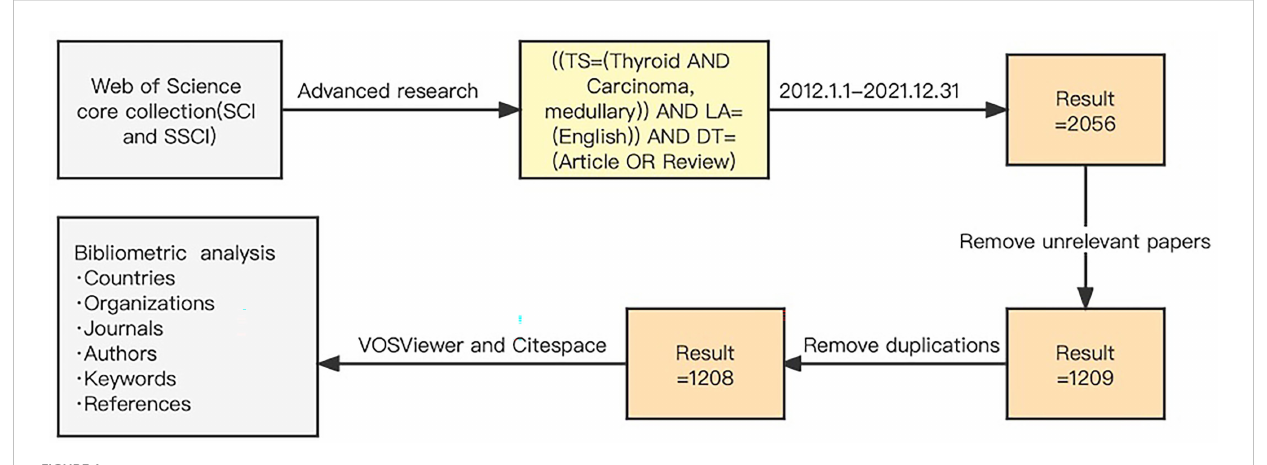
FIGURE 1 Search strategy, data screening and bibliometric analysis